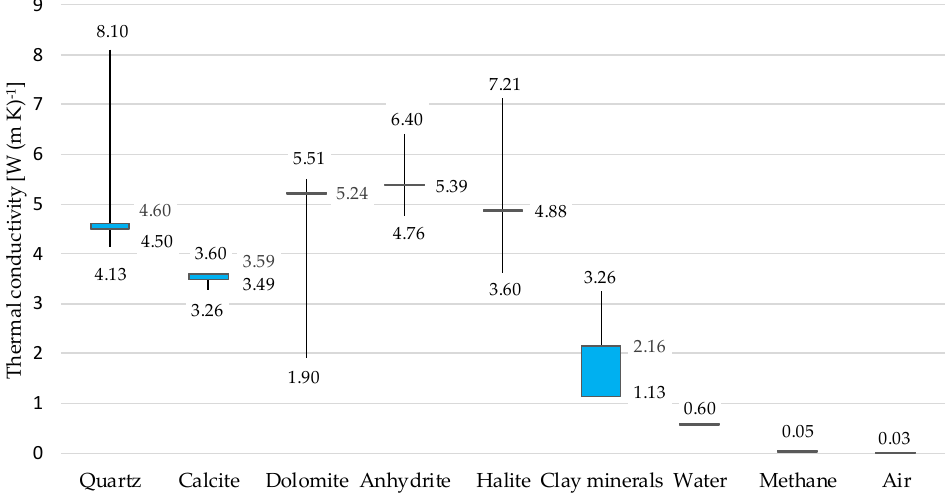
Figure 5. Open-high-low-close chart of thermal conductivity of selected rocks and reservoir media ac- Figure 5. Open ‐ high ‐ low ‐ close chart of thermal conductivity of selected rocks and reservoir media cording to [77,107,110,111,113–118] (OC—blue bars express thermal conductivity values of particular according to [77,107,110–111,113–118] (OC—blue bars express thermal conductivity values of par ‐ rocks and media used for the calculations performed in the ticular rocks and media used for the calculations performed in the study).